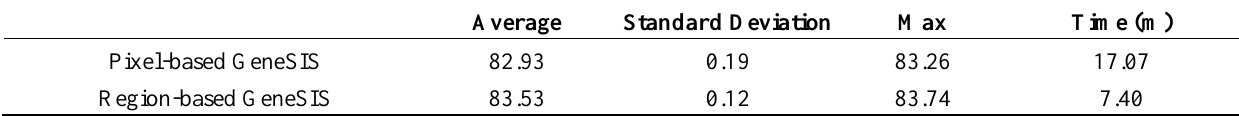
Table 4. Average OA, standard deviation of OA, maximum OA, and execution time for the two GeneSIS versions in Koronia Image.